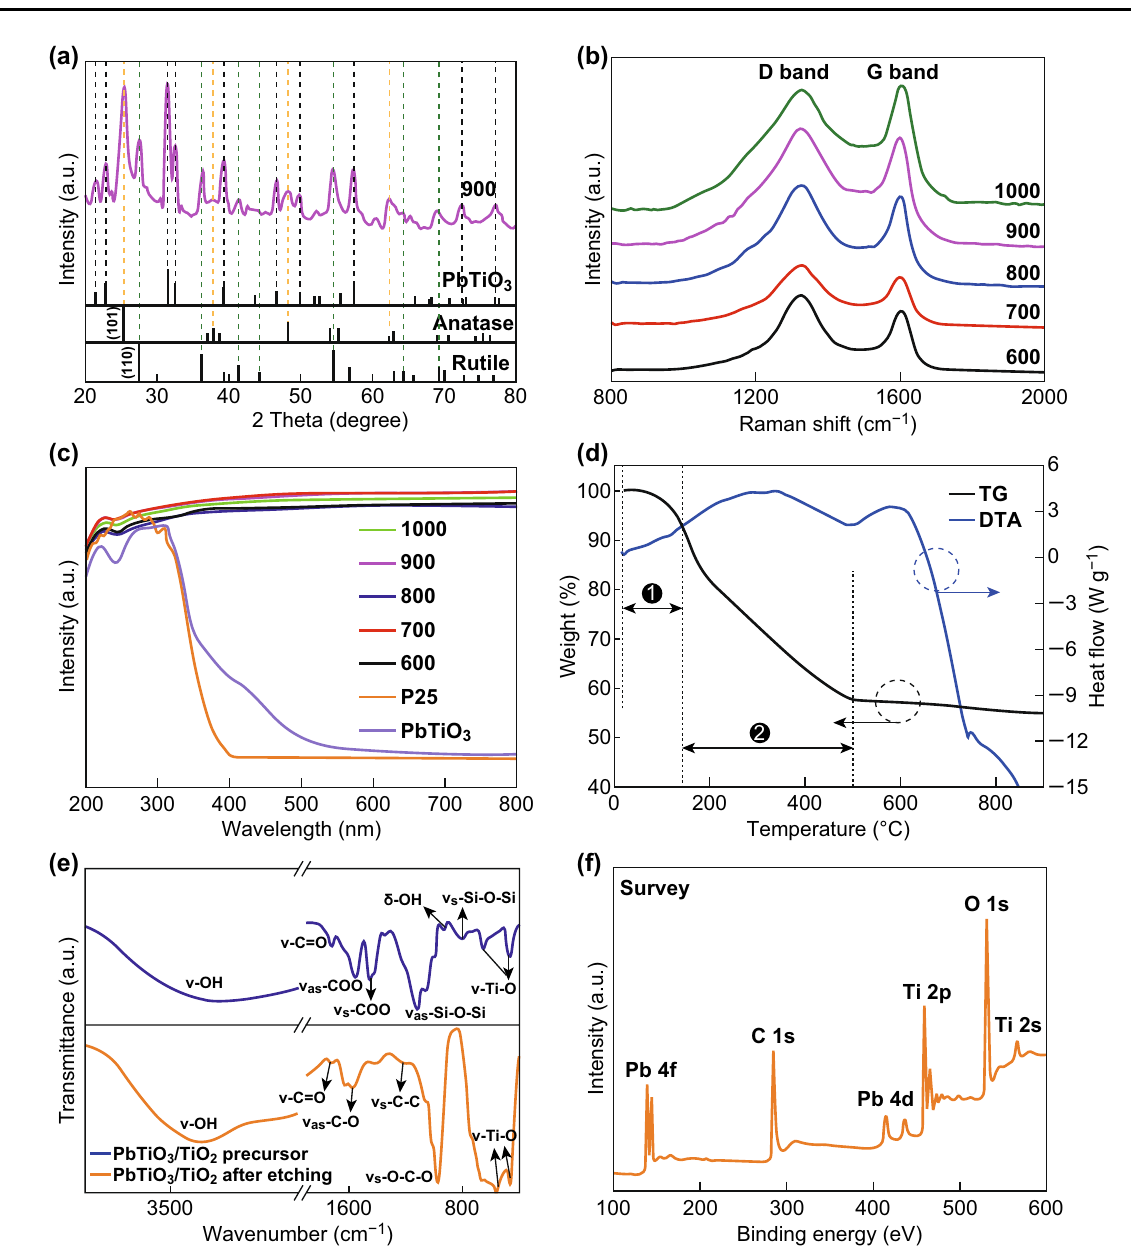
Fig. 1 a XRD patterns, b Raman spectra, and c diffuse reflectance spectra of PTC annealed at different temperatures. d TG and DTA curves of the PTC precursor. e FT-IR spectra of PTC precursors after etching prior to annealing. f The complete XPS survey spectrum of